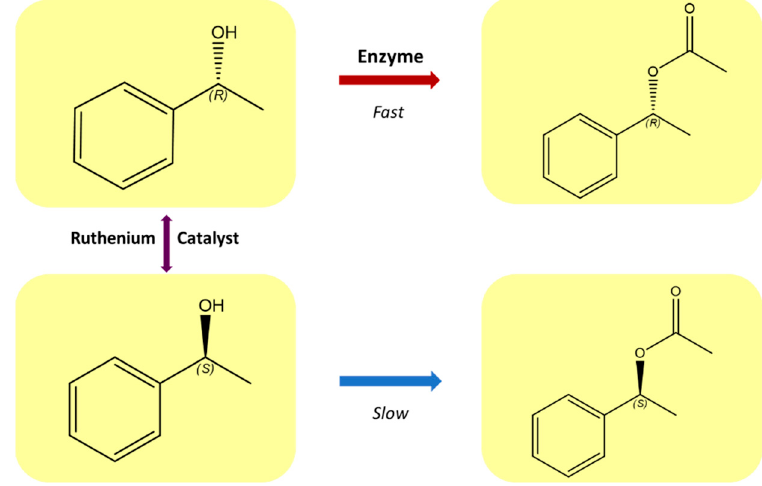
Figure 1. Dynamic kinetic resolution of secondary alcohols.